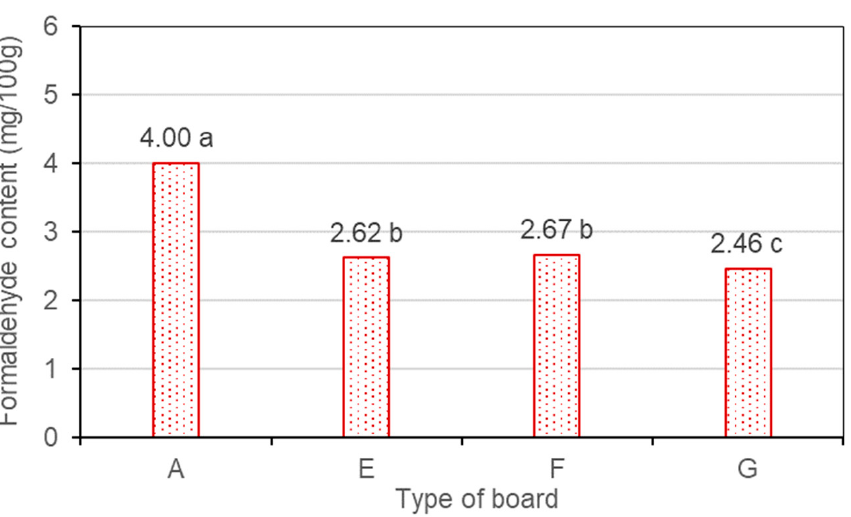
Figure 9. Effect of the amount of MUF resin in adhesive on the formaldehyde content of boards made with wood particles from dead trees. (Averages with the same letter are statistically equal.).